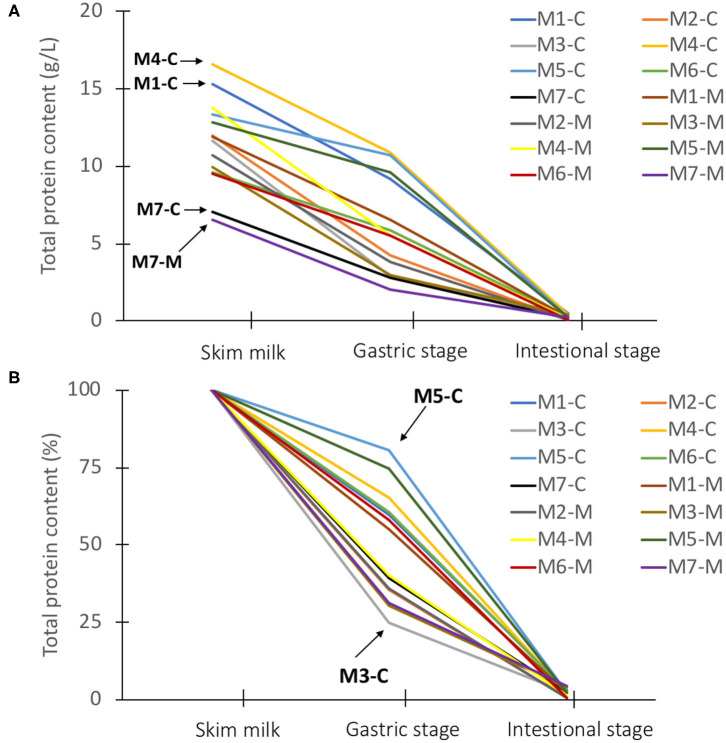
The total BCA protein content (g/L) (A) and total BCA protein content (%) (B) in skim milk for colostrum (week 1) and mature milk (week 4) from 7 Chinese mothers after dilution of the samples, and after gastric and intestinal stage. The total BCA protein concentrations (g/L) in diluted skim milk for colostrum and mature milk of the individual mothers was set to 100%. MX; X = mother. The letter behind the hyphen indicates colostrum (C) and mature milk (M).